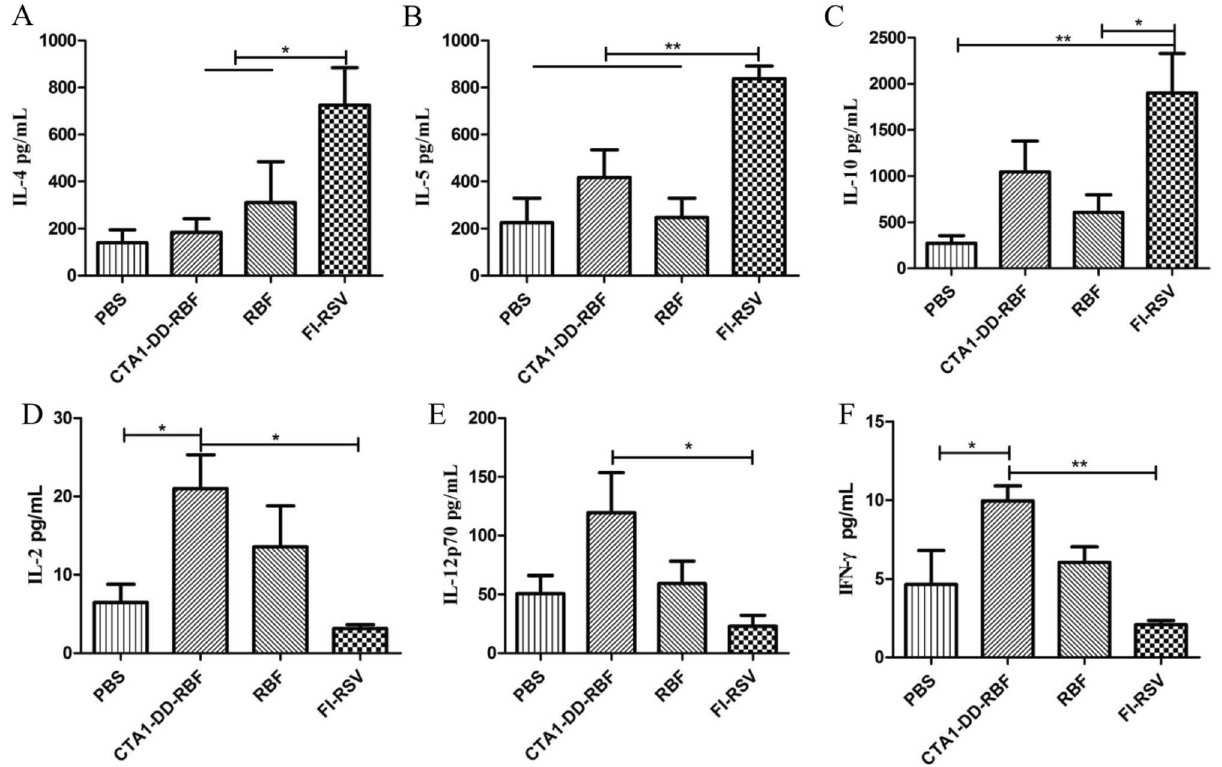
Figure 4. Intranasal vaccination elicited a Th1 cytokine response in bronchoalveolar lavage fluid (BALF). BALF was collected at 14 days after the second immunization. We assessed the contents of Th1-type cytokines (IL-2, IL-12p70, IFN-γ) and Th2-type cytokines (IL-10, IL-4, IL-5) in BALF using ELISA kits (Dakewei, Beijing, China) according to the manufacturer’s instructions. Statistically significant differences were determined by one-